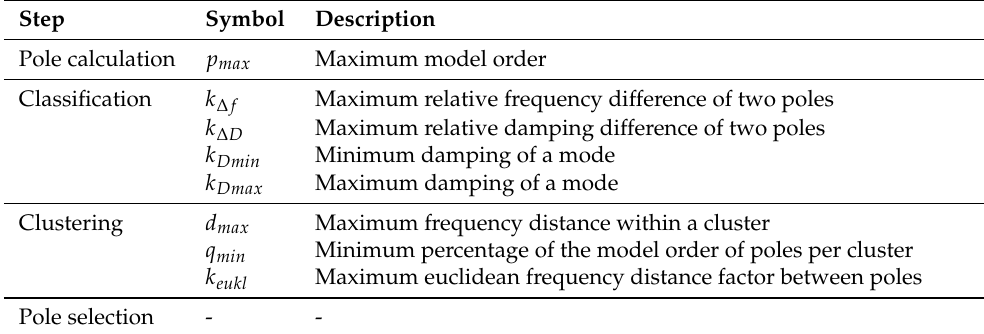
Table 1. Overview of hyperparameters used in the modal parameter estimation; the classification parameters are defined similar to Reynders et al. [12] and Neu et al.